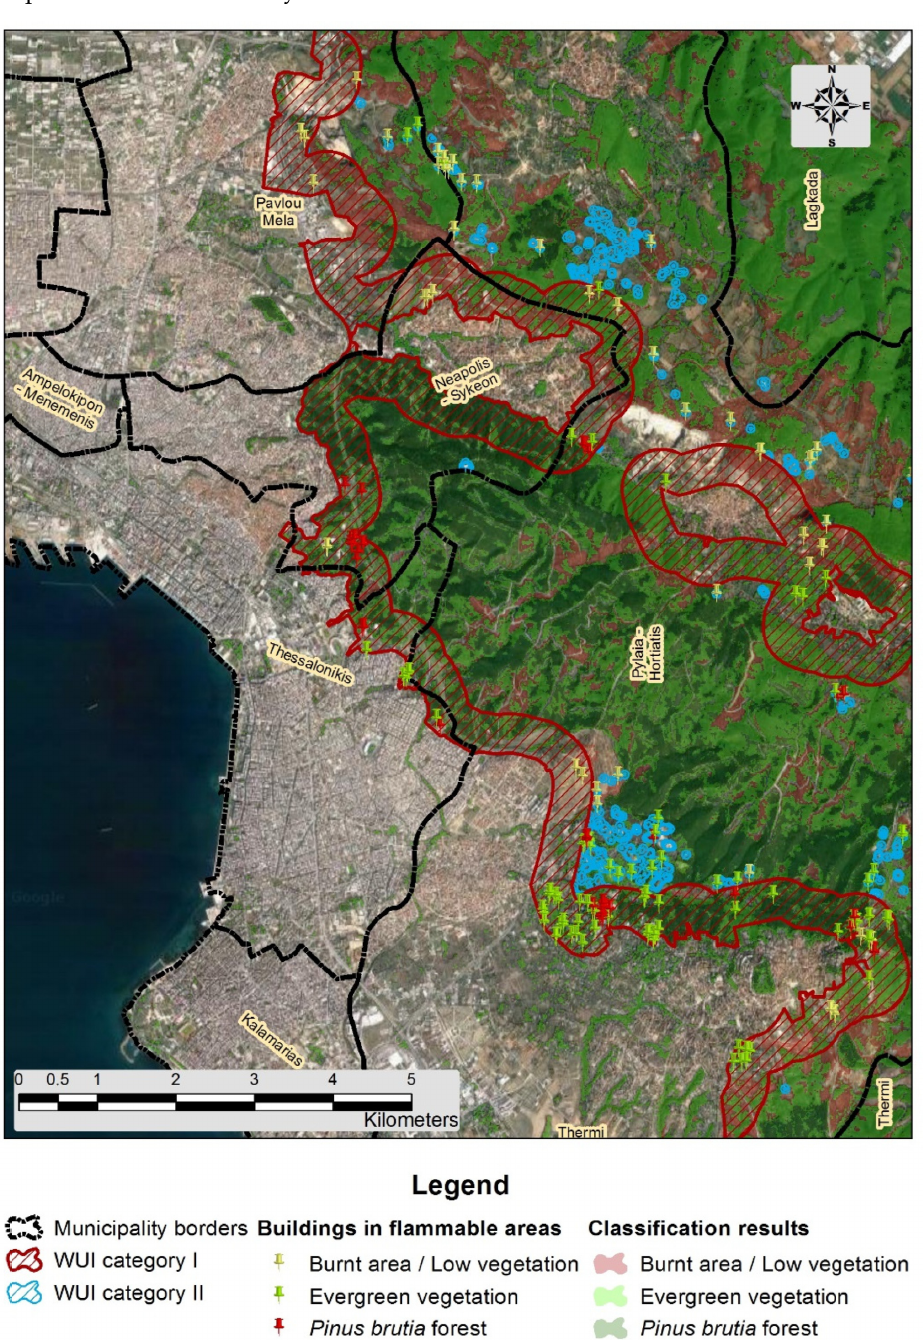
Figure 4. Map showing the two WUI categories, the vegetation classes within the WUI areas, and the buildings in areas over 2.5